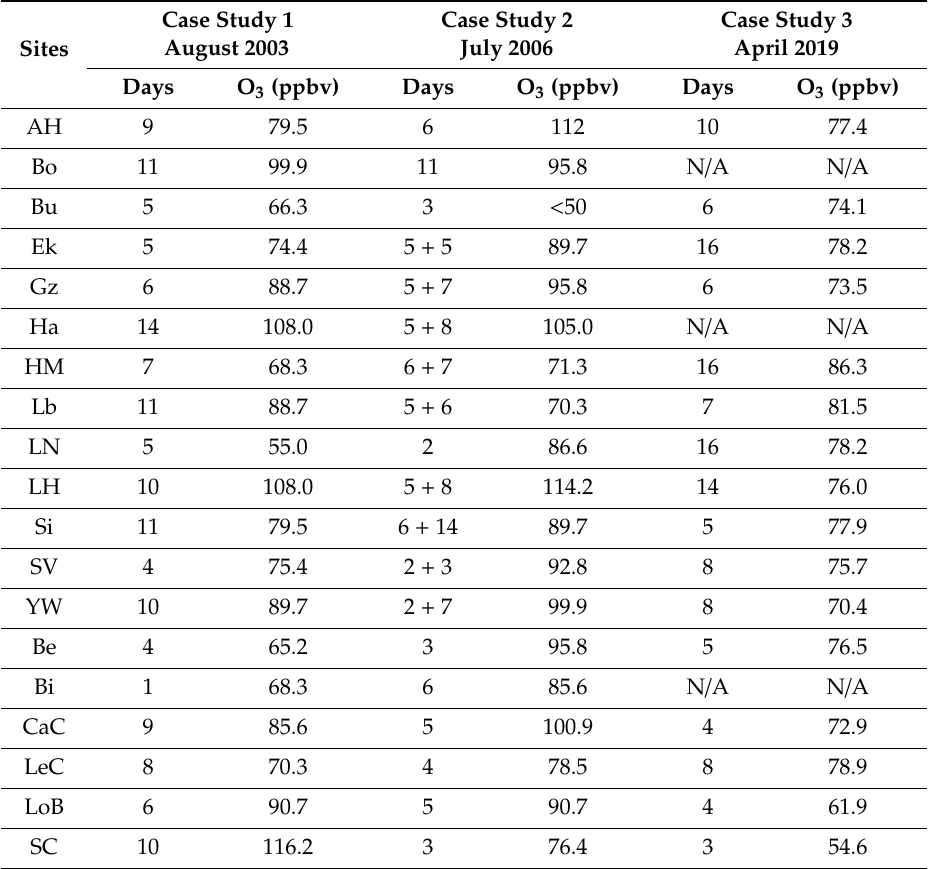
Table 3. Magnitude and duration of case